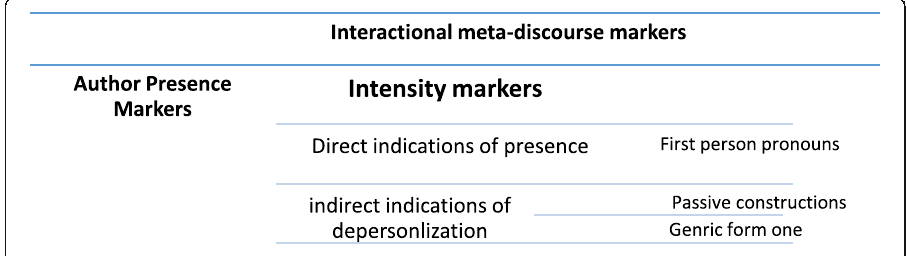
Fig. 1 A Synthesized Typology of Author Presence